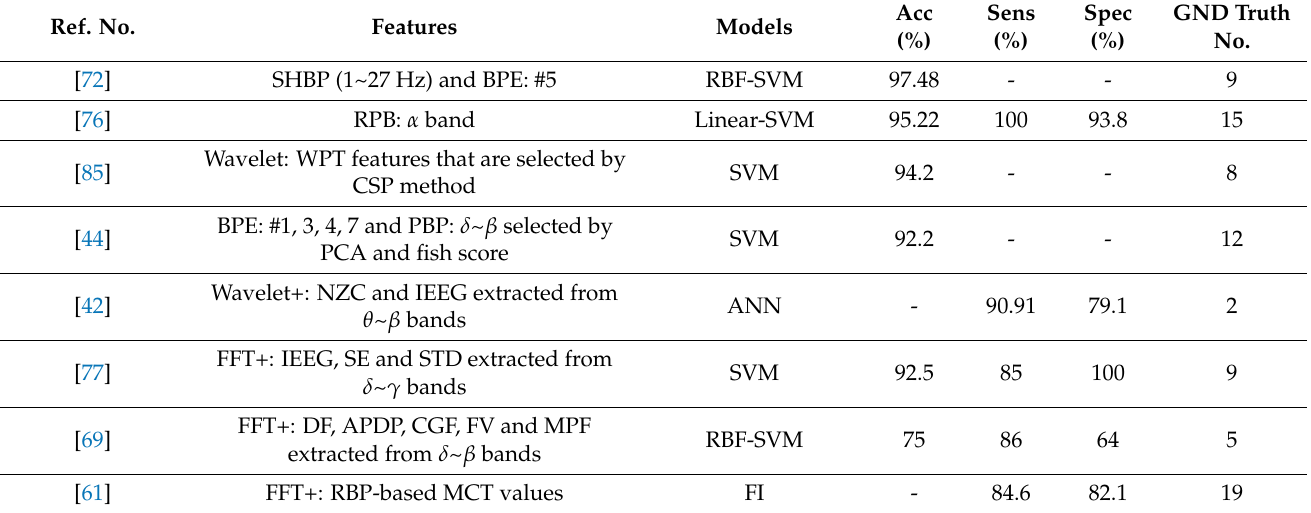
Table 6. EEG-based DDD Accuracies obtained by using Binary Classification Models and Various Features and Ground